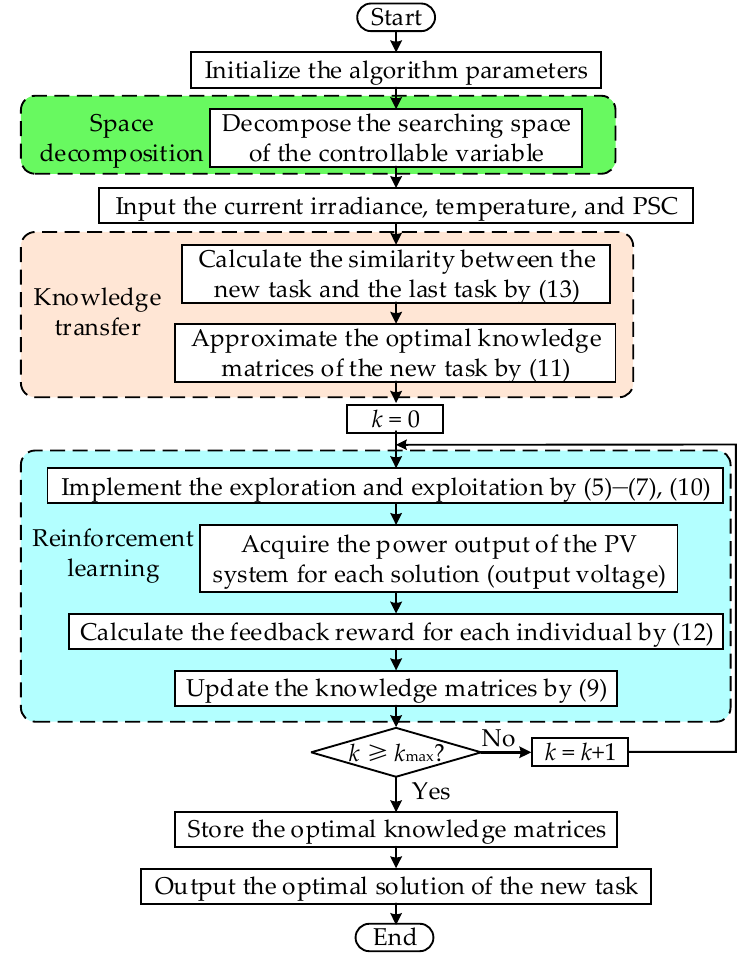
Figure 4. Overall flow diagram of TRL for MPPT. PSC: Partial Shading Conditions.